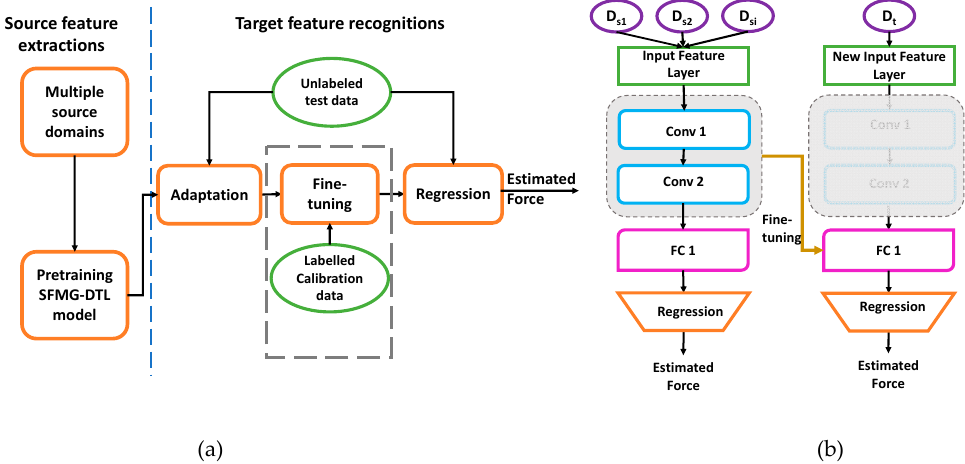
Figure 4. FMG-based transfer learning: ( a ) estimating applied interactive forces via SDA and SDG and ( b ) fine-tuning process of the pretrained SFMG-DTL model.